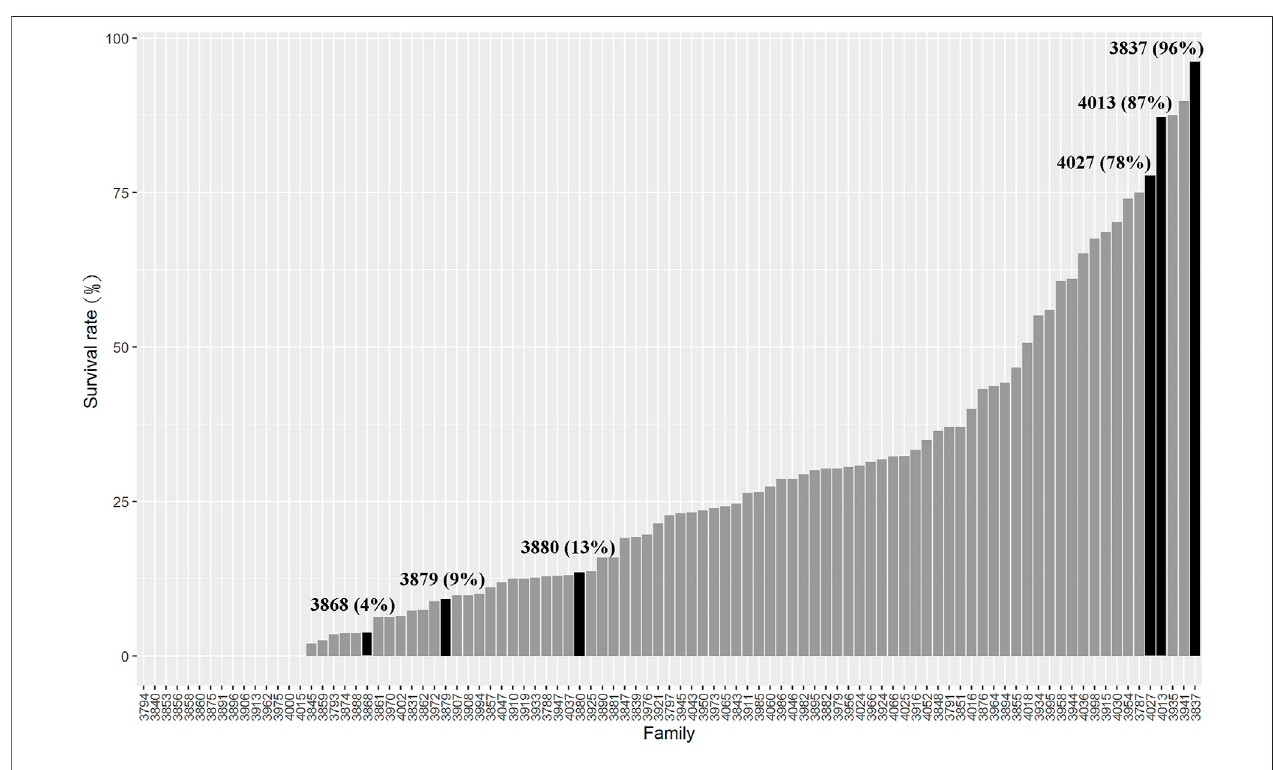
FIGURE 1 | Survival rate of different families challenged by VP AHPND